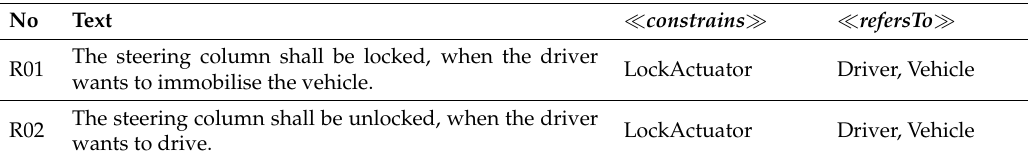
Table 3. ESCL Requirements based on